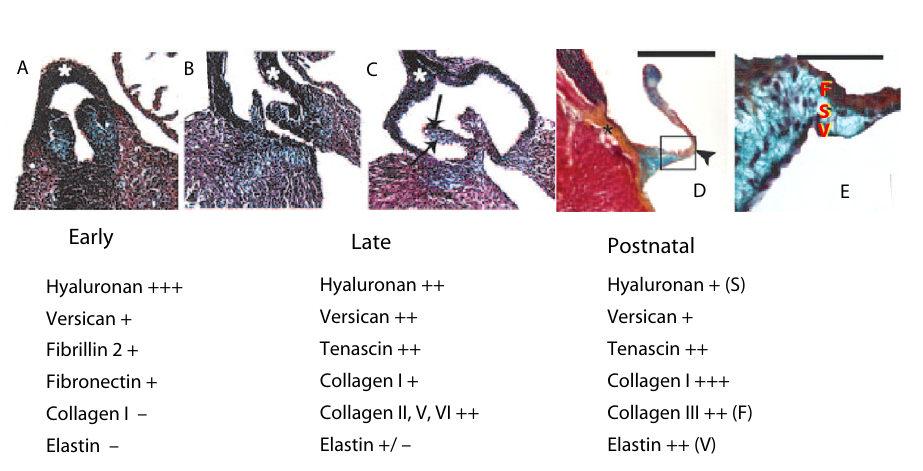
Figure. 3 Protein expression in extracellular matrix remodeling. ( + ) and ( − ) indicate degrees of expression. S, Spongia;V,ventriculariaus;F,Fibrosa.PicturesexamineMovat’spentachromestainofextracellularmatrix(ECM) organization and valvular interstitial cell (VIC) compartmentalization within mouse semilunar valves as seen in the (A) cushion, (B) elongation, and (C) remodeling period. The white asterisk indicates the aorta; arrows highlight cusp and leaflet remodeling. (D) Showa mature valve cusps, the black asterisk marks the annulus, the arrow marks the leading edge ventricularis. The boxed area is magnified in (E). Elastin fibers are black, collagen yellow, proteogylcans blue, cell nuclei purple, and muscle red. Adapted from [46,50,54,55].